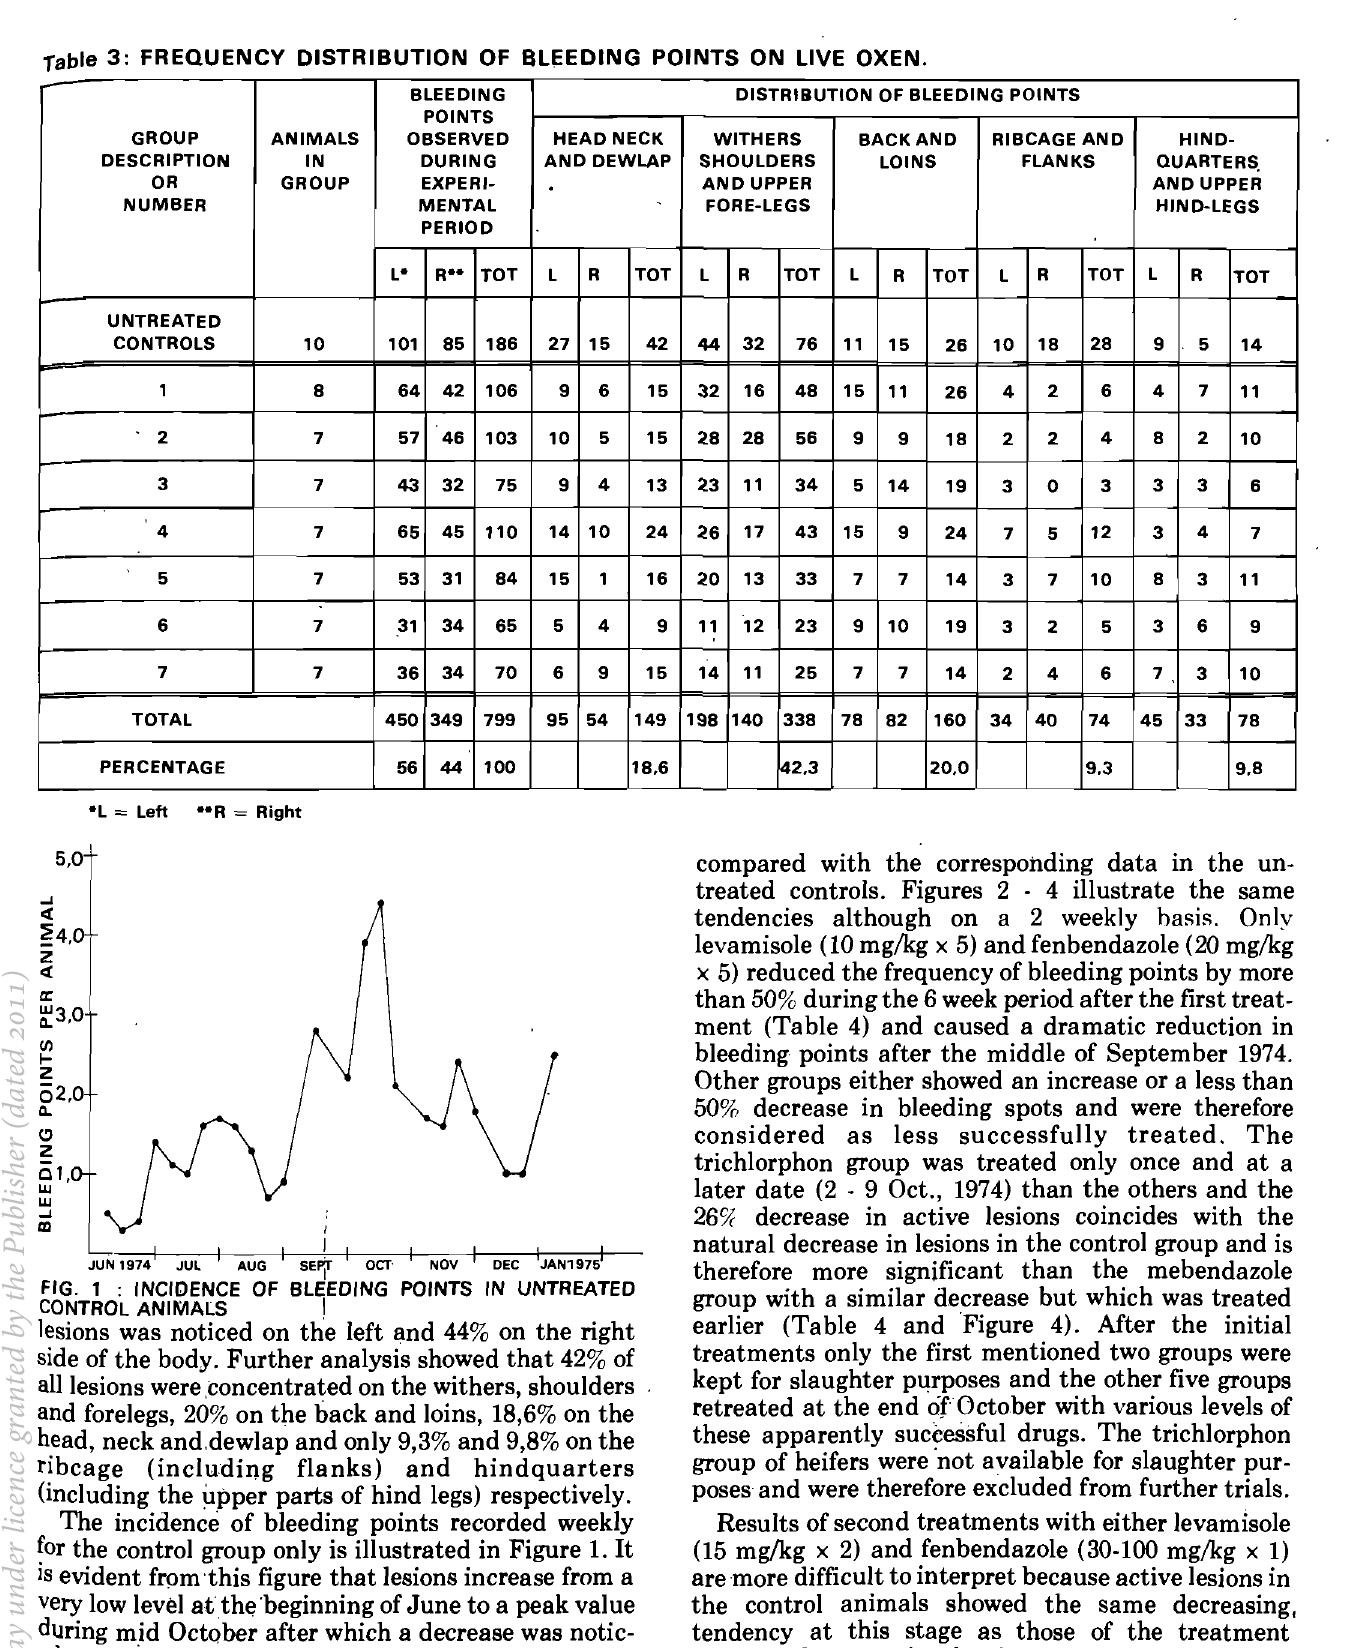
5,0 .... c{ ~4, z c{ cr ~3,O (/J f- z 02,0 c.. (!) z Ql, w w ....